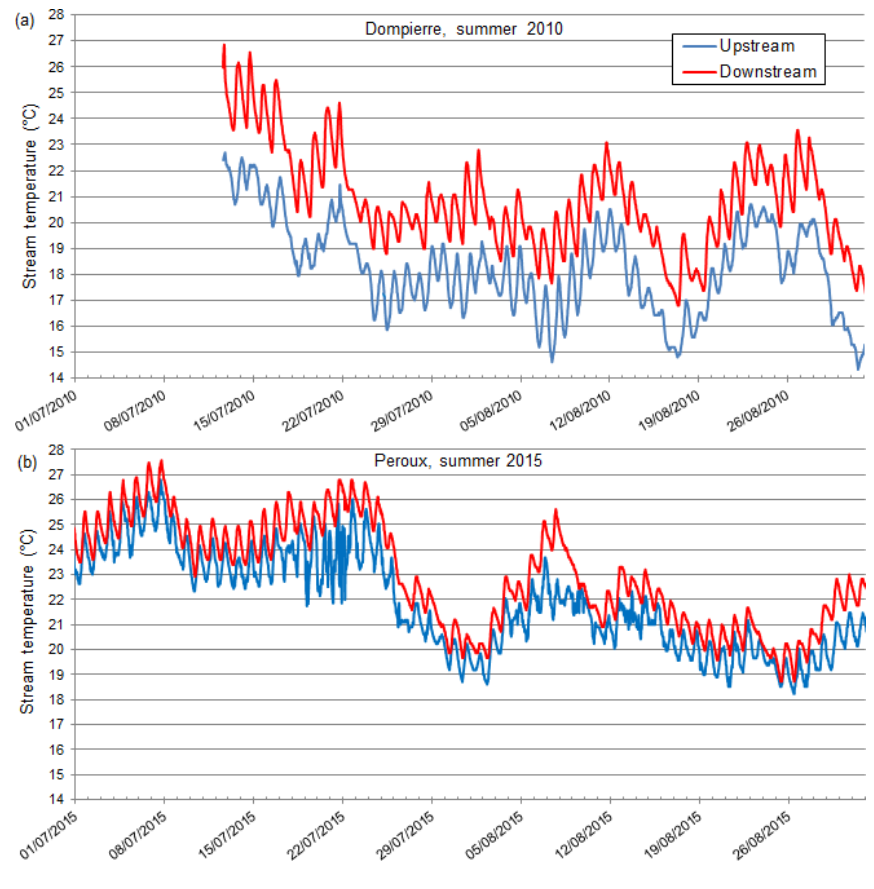
Figure 3. Time series of water temperatures upstream (blue line) and downstream (red line) of the (a) Dompierre and (b) Peroux dams in the Veyle stream (2010 and 2015, two warm summer years, respectively, + 1 . 1 and 2 ◦ C, Table 2). These example sites are illustrative of the group B typology, where both T min and T max are increased downstream.